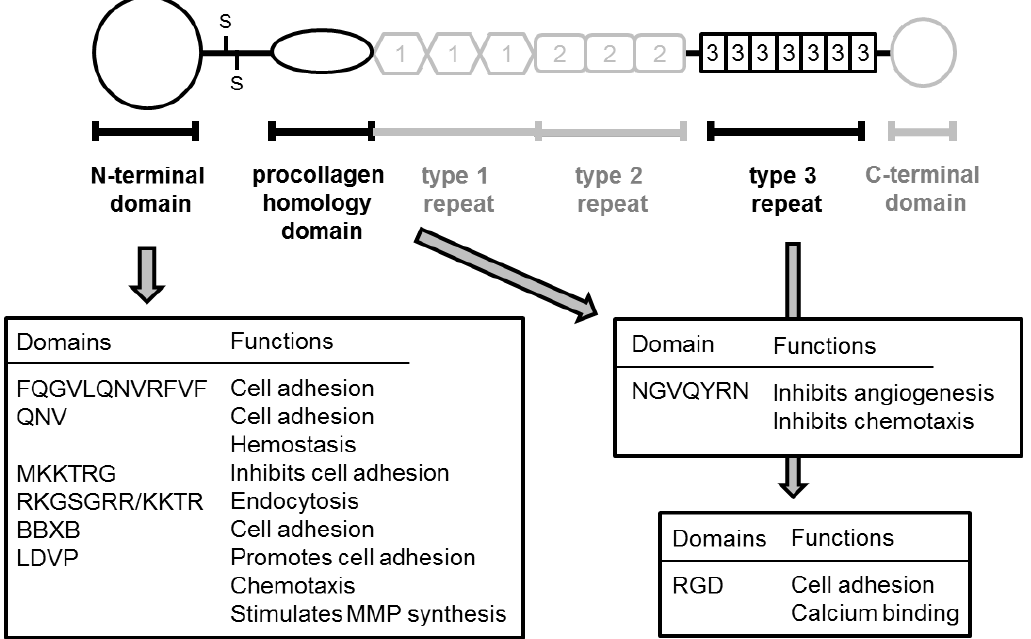
Figure 2. Pathological function of TSP-1-derived peptides in N -terminal, procollagen homology, and type 3 repeat domains.